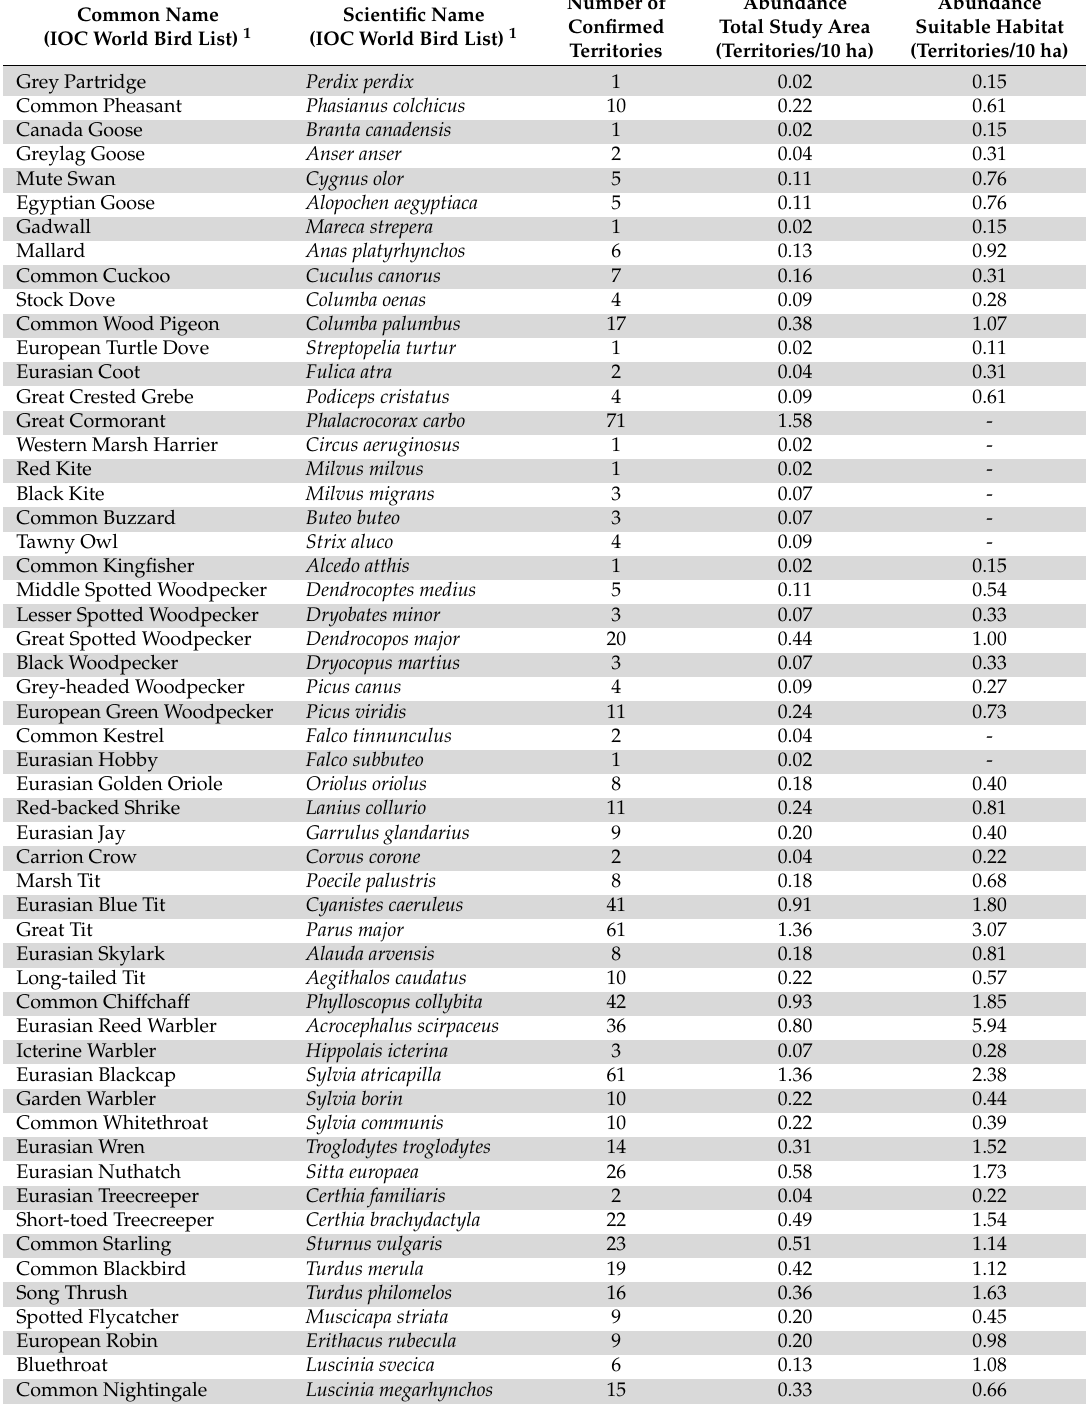
Table 1. List of breeding bird species at “Lampertheimer Altrhein” in 2017 including number of territories, abundance for the total study area, and abundance for suitable habitat. Species are sorted according to the systematic order of the IOC World Bird